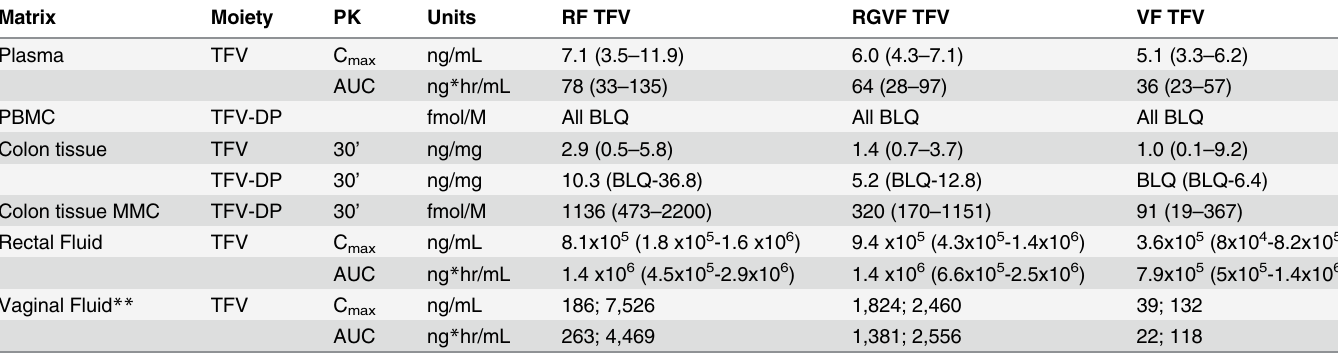
Table 5. Pharmacokinetic data are summarized as median (interquartile range). *